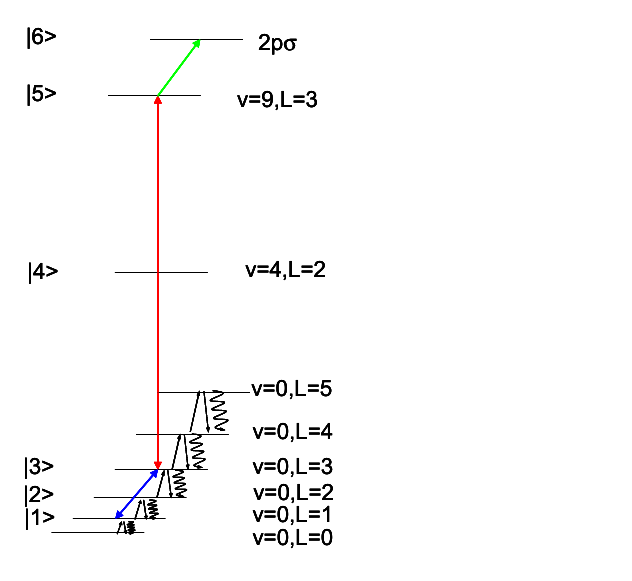
Figure 2. The closed set of energy levels addressed by the THz/infrared double resonance two-photon spectroscopy scheme mediated by the blackbody radiation.